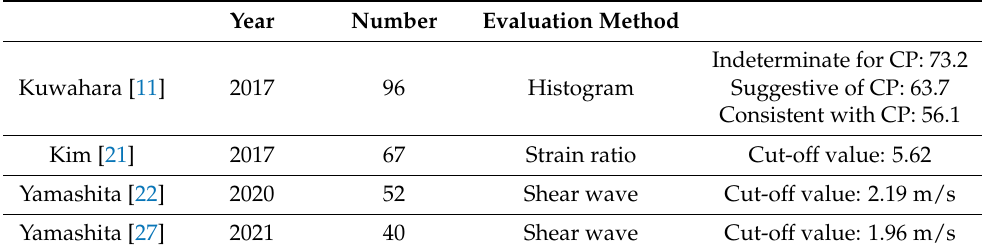
Table 1. Usefulness of endosonography–elastography (EUS-EG) in chronic pancreatitis. Year Number Evaluation Method Indeterminate for CP: 73.2 Kuwahara [11] 2017 96 Histogram Suggestive of CP: 63.7 Consistent with CP: 56.1 Kim [21] 2017 67 Strain ratio Cut-off value: 5.62 Yamashita [22] 2020 52 Shear wave Cut-off value: 2.19 m/s Yamashita [27] 2021